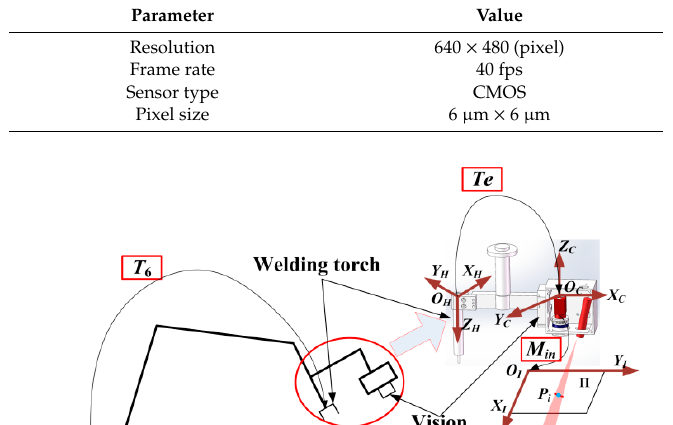
Table 1. Camera parameters.